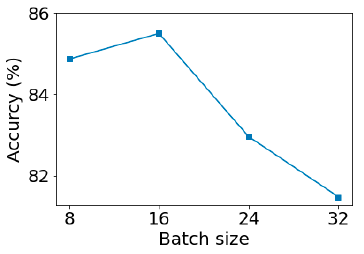
Figure 11. Performance of 1D CNN by varying batch size.